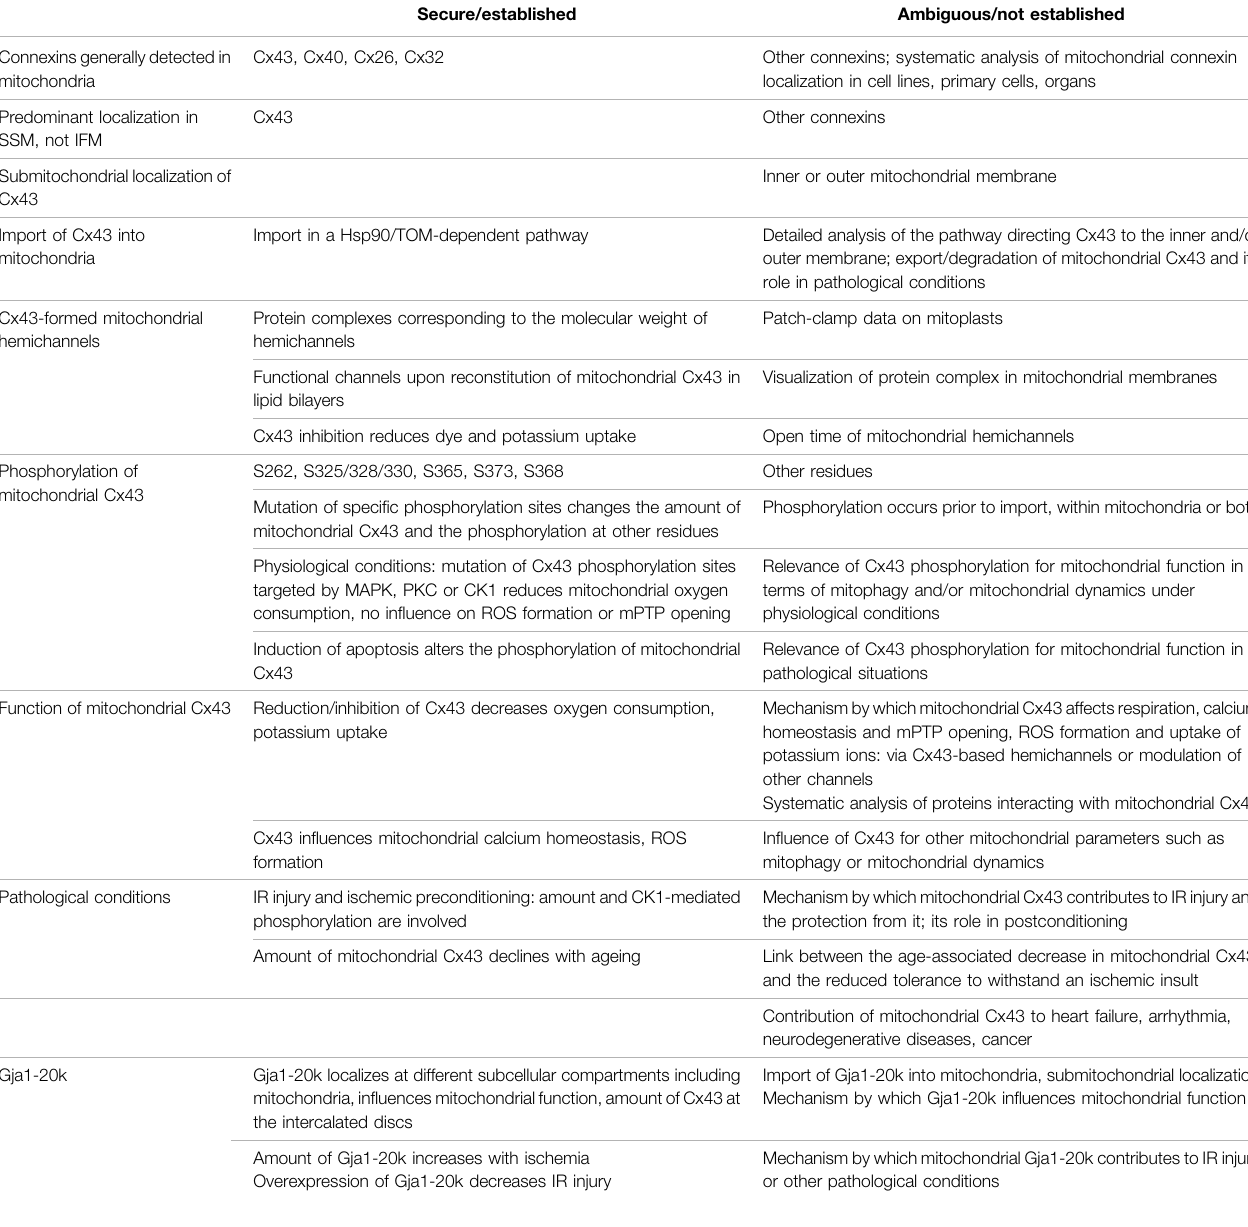
TABLE1| Secured/establishedfactsandambiguous/notestablished issuesonmitochondrialconnexins,especiallyCx43.CK1,caseinkinase1;Hsp90,heatshockprotein 90; IFM, inter fi brillar mitochondria; IR, ischemia/reperfusion; MAPK, mitogen-activated protein kinase; mPTP, mitochondrial permeability transition pore; PKC, protein kinase C; ROS, reactive oxygen species; S, serine; SSM, subsarcolemmal mitochondria; TOM, translocase of the outer